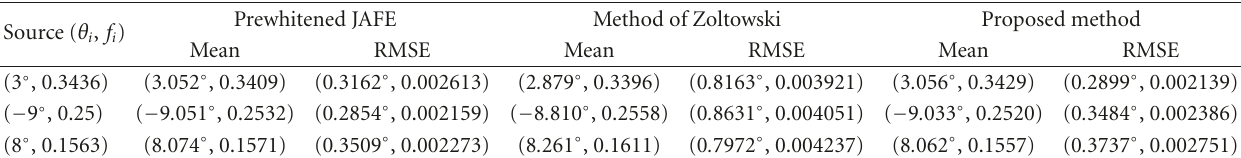
Table 2: Means and RMSEs of three methods based on the 20 estimates when used with experimental data.